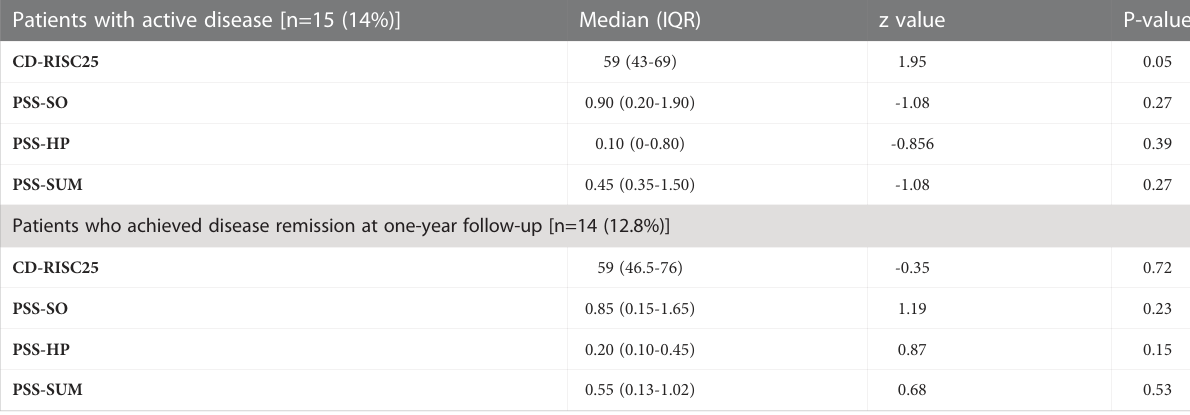
TABLE 4 Correlation between disease activity and questionnaire scores, and between those who reached disease remission at one-year follow- up and questionnaire scores. Patients with active disease [n=15